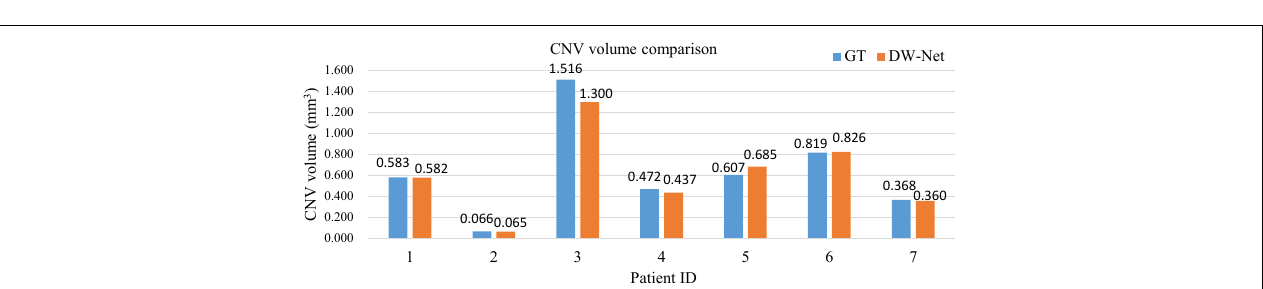
FIGURE 6 | Histogram of choroid neovascularization (CNV) volume